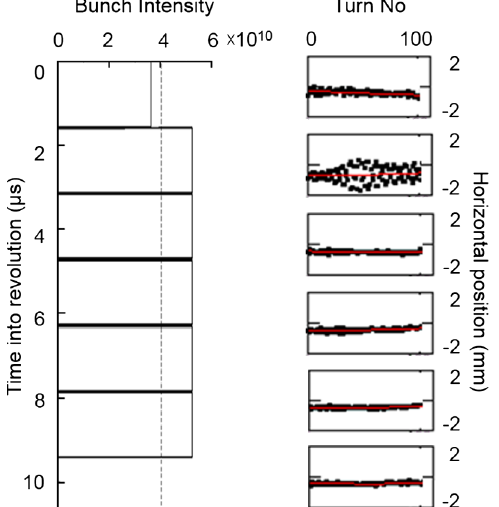
chamber.FIG. 1. The first batch above the threshold intensity suffers the blowup after injection into the ring [3]. The bunch intensities of six consecutive injections in the recycler are shown on the left. The first bunch train (top) has the intensity below the threshold (dashed line), and the following injections are above the thresh- old. The vertical axis shows the injection position of the bunch trains in the ring. Right: turn-by-turn measurements of beam center positions of the corresponding bunch trains during the first 100 turns after the injection. Only the first batch above the threshold intensity becomes unstable.